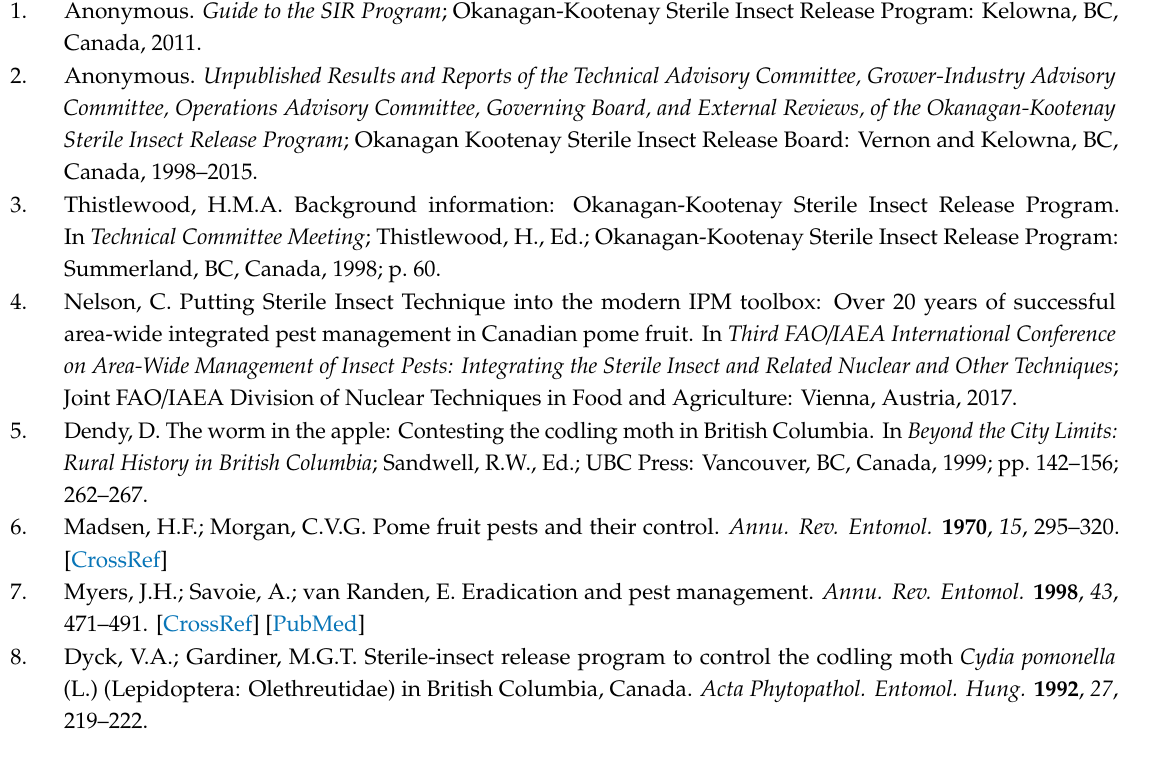
Table S1: Locations of selected documents at internet sources on 15 August